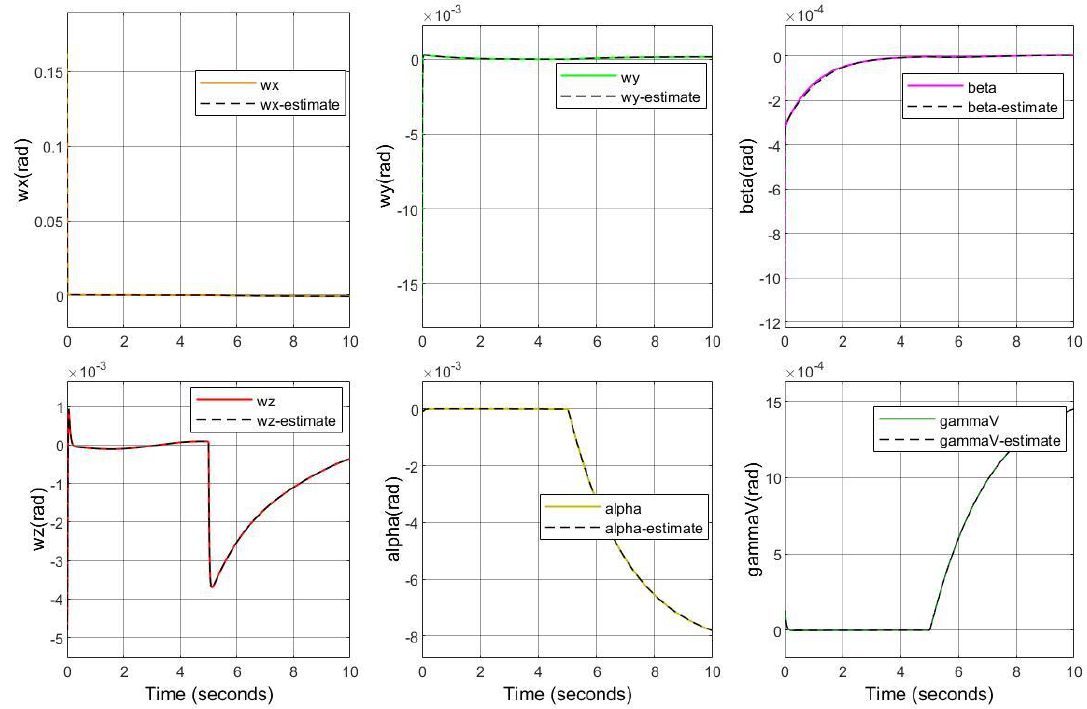
Figure 4. Detection simulation results of actuator stuck fault from input 1.